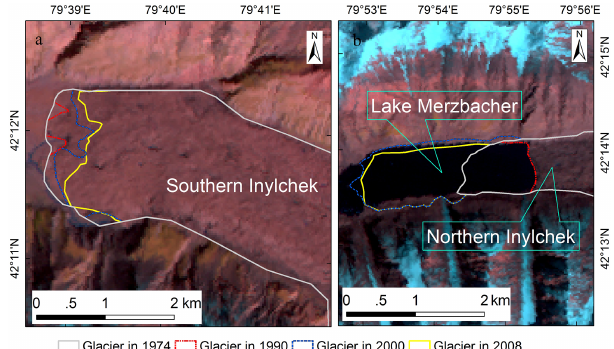
Figure 2. Changes in glacier front position of SIG and NIG between ∼ 1975 and 2007. The background Landsat TM image was acquired in